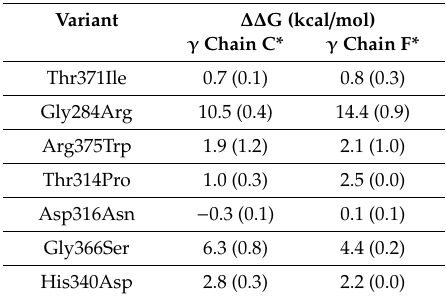
Table 1. Free energy change ( ∆∆ G) in protein folding of fibrinogen γ amino acid